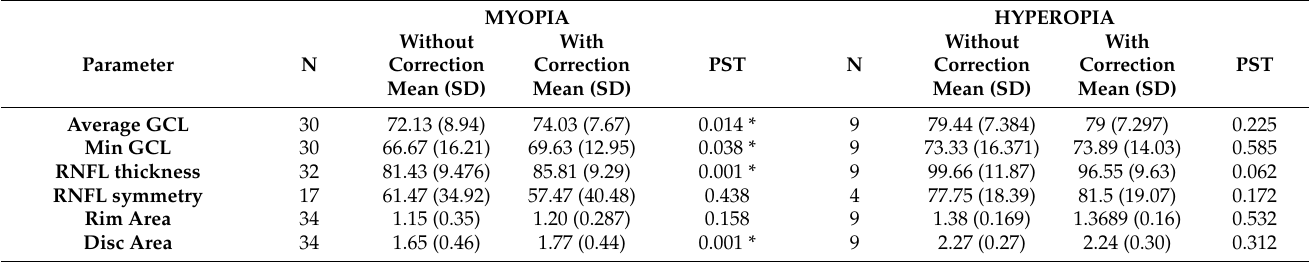
Table 1. Descriptive analyses; PST: Paired-Sample t -test; N: number of cases; p < 0.05 marked with *.